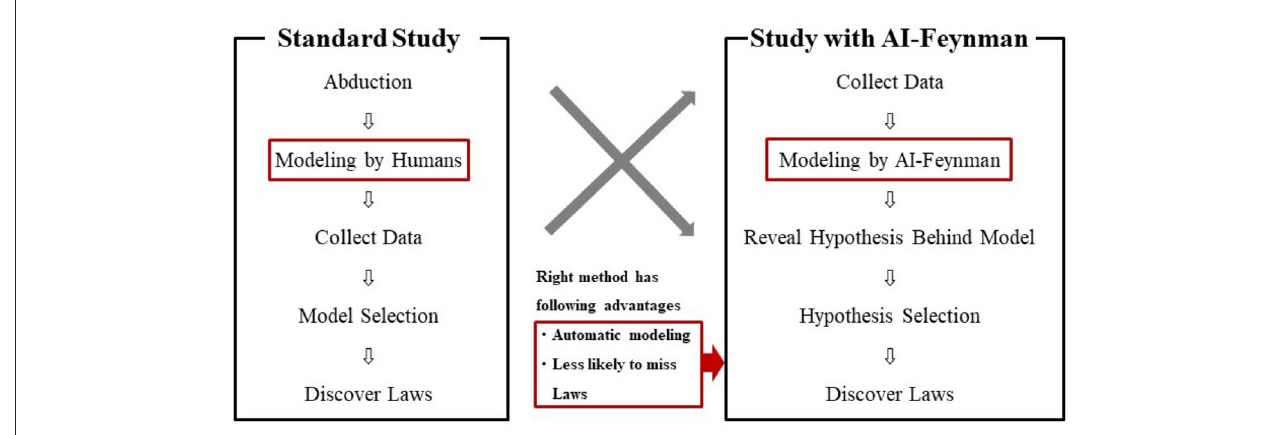
FIGURE7 Comparison of standard study and study with AI-Feynman.